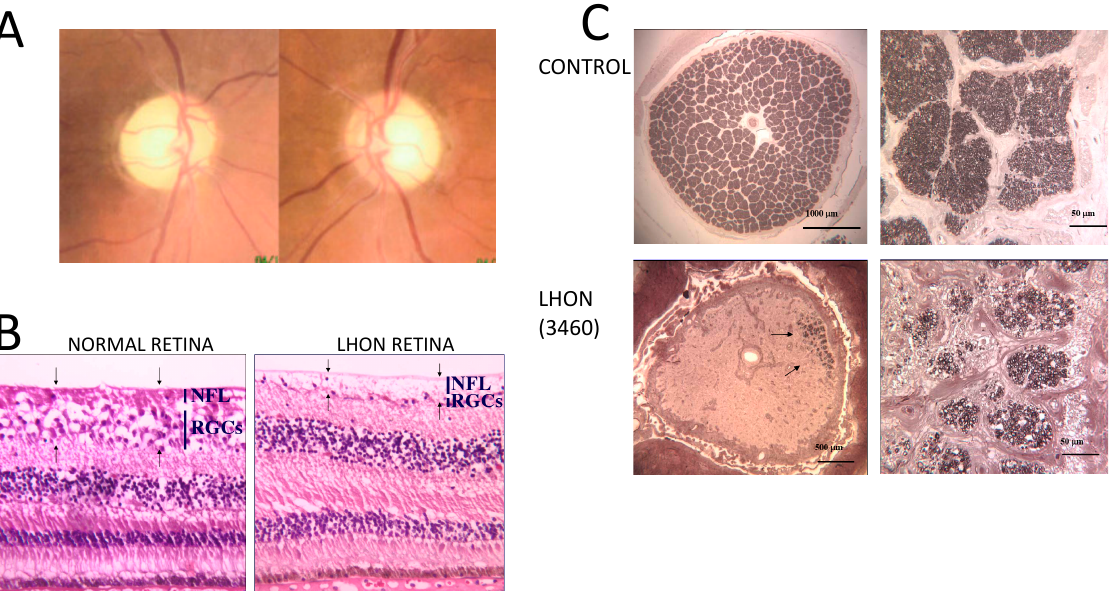
Figure 6. The retina in LHON. ( A ) Bilateral optic atrophy in chronic LHON. ( B ) In LHON the retinal neuronal fibres layer (NFL) and retinal ganglion cells (RGCs) layer are severely atrophic. Modified from from Maresca A and Carelli V, 2021 [18], H&E staining. ( C ) Loss of nerve fibres in a transverse section of the optic nerve of an LHON patient with the MT-3460 mutation, and in a magnified detail, compared with a control; Courtesy of Alfredo A. Sadun and Fred N. Ross-Cisneros.